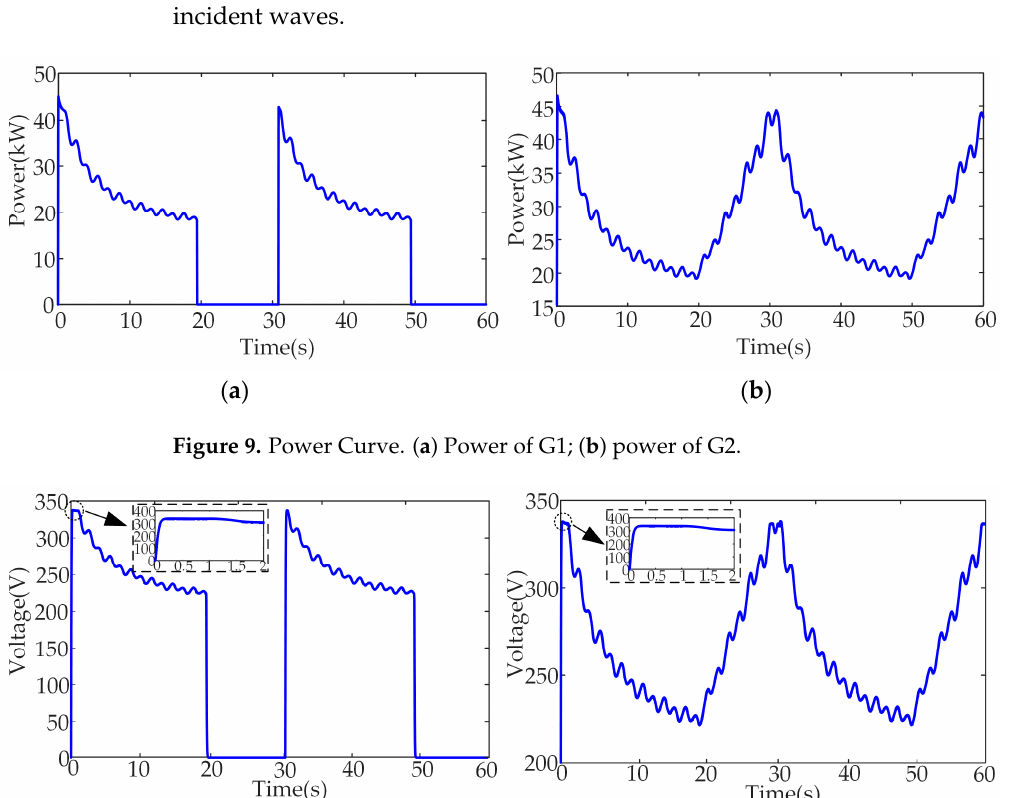
Figure 8. Speed under SMC control. ( a ) Speed of G1; ( b ) speed of G2.